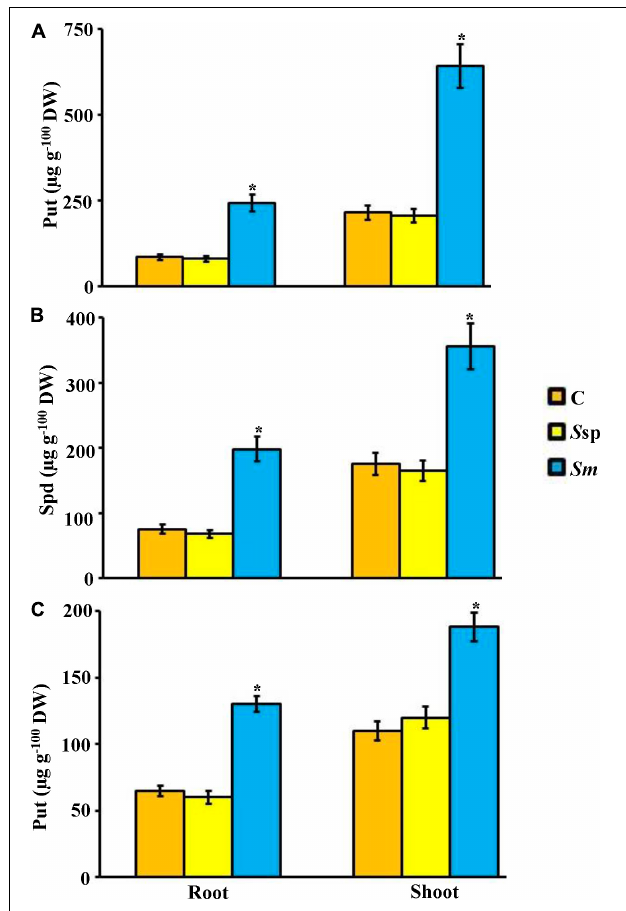
FIGURE 7 | Effect of the endophytic Streptomyces mutabilis UAE1 on endogenous PA contents of mangrove. Endogenous contents of (A) Put, (B) Spd, and (C) Spm in mangrove root and shoot tissues after treatment with C, S sp, and Sm . Mangrove seedlings were grown in an evaporative-cooled greenhouse and maintained at 30 ± 2 ◦ C. Values are means ± SE of 16 replicates for each treatment from two different independent experiments. Mean values followed by an asterisk are significantly ( P < 0.05) different from each other according to Fisher’s protected LSD test. Bars represent SE. Endogenous contents of Put, Spd, and Spm were measured at 9 months post planting the inoculated mangrove propagules. DW, dry weight; PA, polyamine; C, control (non-inoculated inorganic salt starch broth); S sp, PA-non-producing isolate #5 ( Streptomyces sp. 19-388); Sm , PA-producing isolate #24 ( S. mutabilis UAE1); PA, polyamine, Put, putrescine; Spd, spermidine; Spm, spermine.